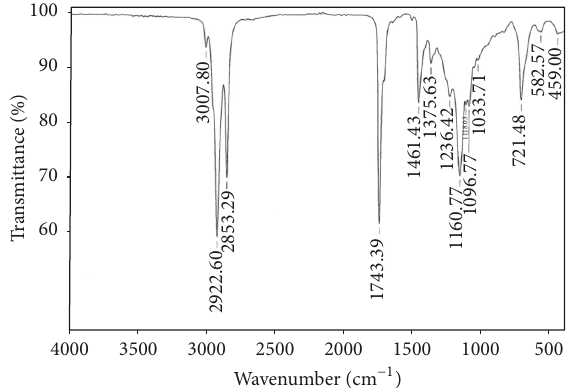
Figure 1: FTIR spectrum of the raw oil from rice bran.